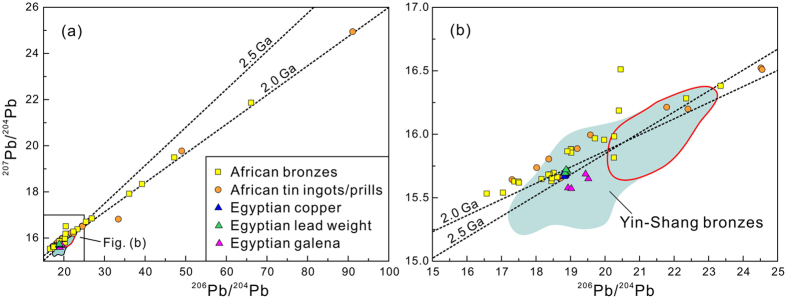
206Pb/204Pb versus 207Pb/204Pb diagram for ancient bronzes from China279 in comparison with tin ingots/prills, bronzes and slags from South Africa and Zimbabwe36, and from copper, lead and galena from the 18th Dynasty of Ancient Egypt42.Yin-Shang bronzes, and Africa metals plot roughly along the same line. Metals from the 18th Dynasty have homogenous lead isotopes, probably due to repeated recycling. Nonetheless, metals from Ancient Egypt plot in the field defined by Yin-Shang bronzes.